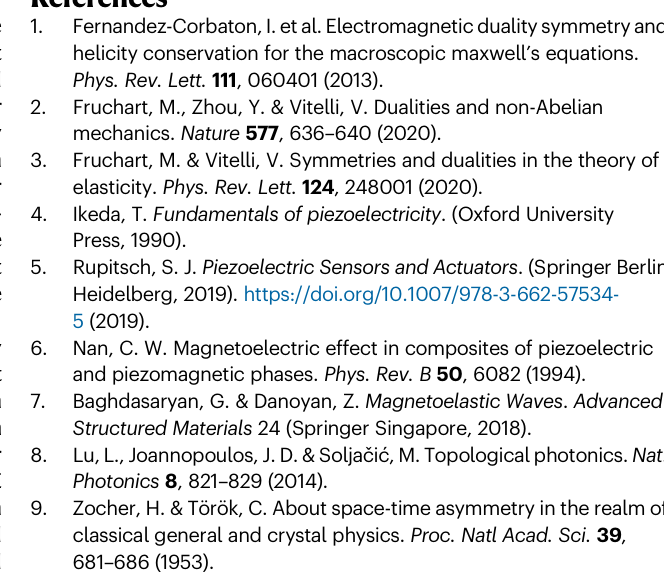
structureof the PZM phononiccrystal featuring two topologicalbands with C=±1. c SimulationresultsshowingCESsbetweenthenet-charge-neutralphononicChern insulator and harder elastic material like Fig.